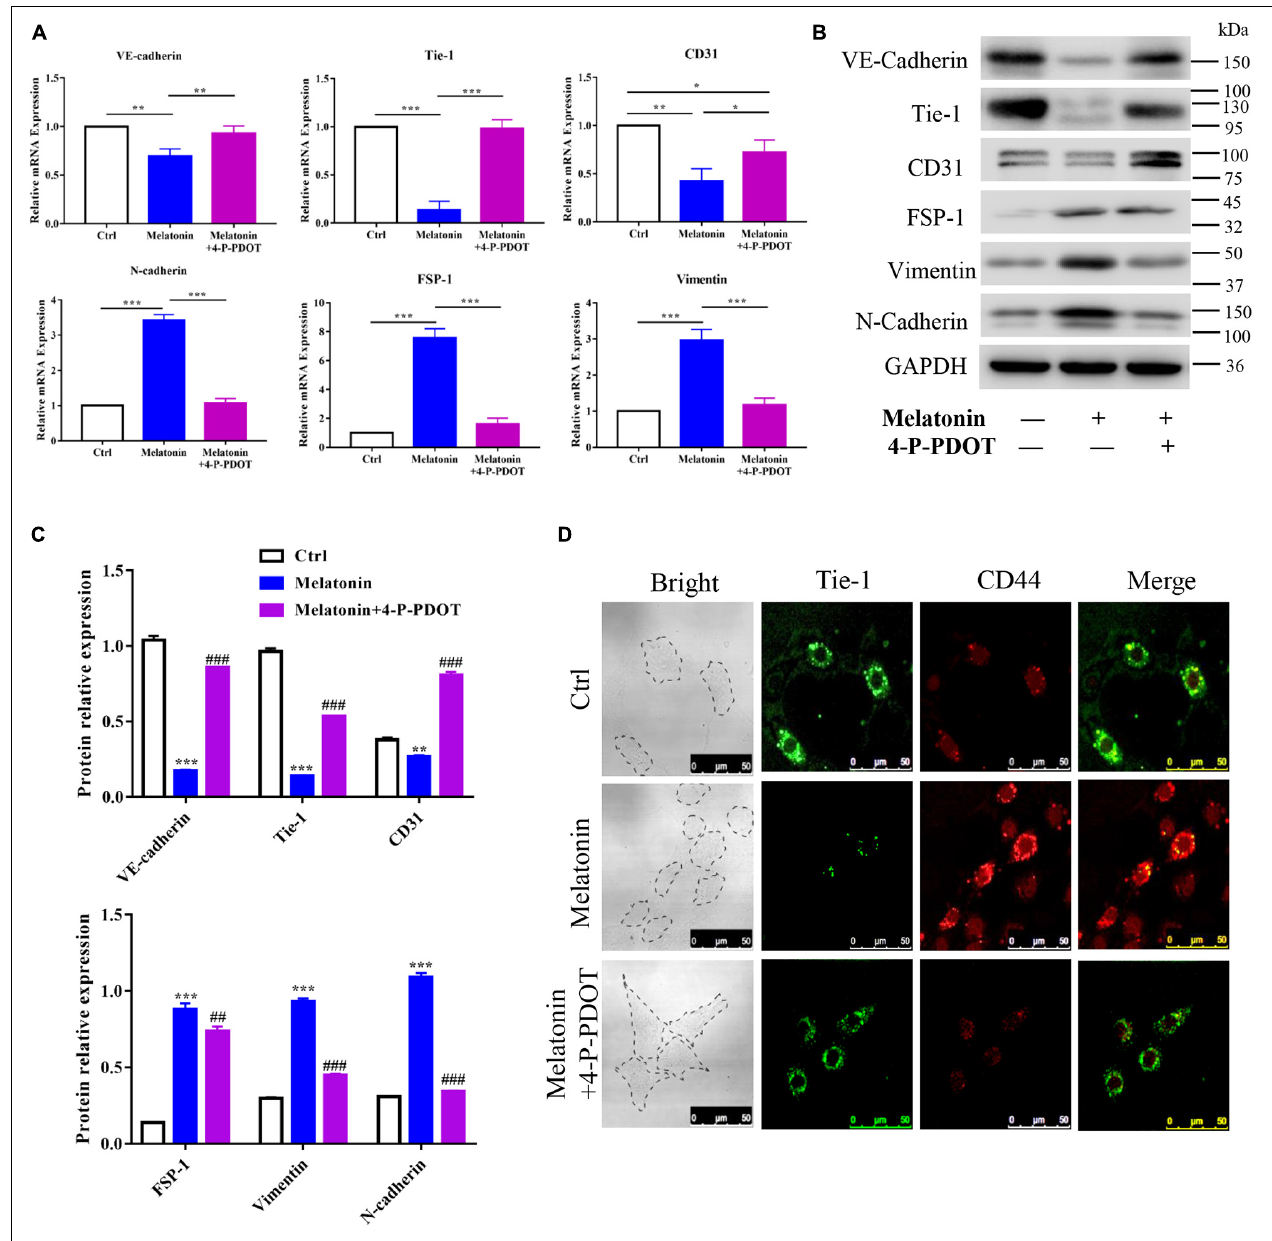
FIGURE 7 | Role of the melatonin-MT2 pathway in the induction of EndMT. Primary RAOECs were induced to undergo EndMT with melatonin in the presence or absence of 4-P-PDOT for 2 weeks. (A,B) Quantitative RT-PCR and western blot with protein quantification (C) analyses showed that 4-P-PDOT reversed the melatonin-induced expression of endothelial markers and mesenchymal markers. (D) IFC staining also showed a reduction in the expression of MSC markers in the melatonin- and 4-P-PDOT-treated group. The data represent the mean ± SD. * P < 0.05, ** P < 0.01, and *** P < 0.001 versus the control group and melatonin group. ## P < 0.01, ### P < 0.001 versus the melatonin